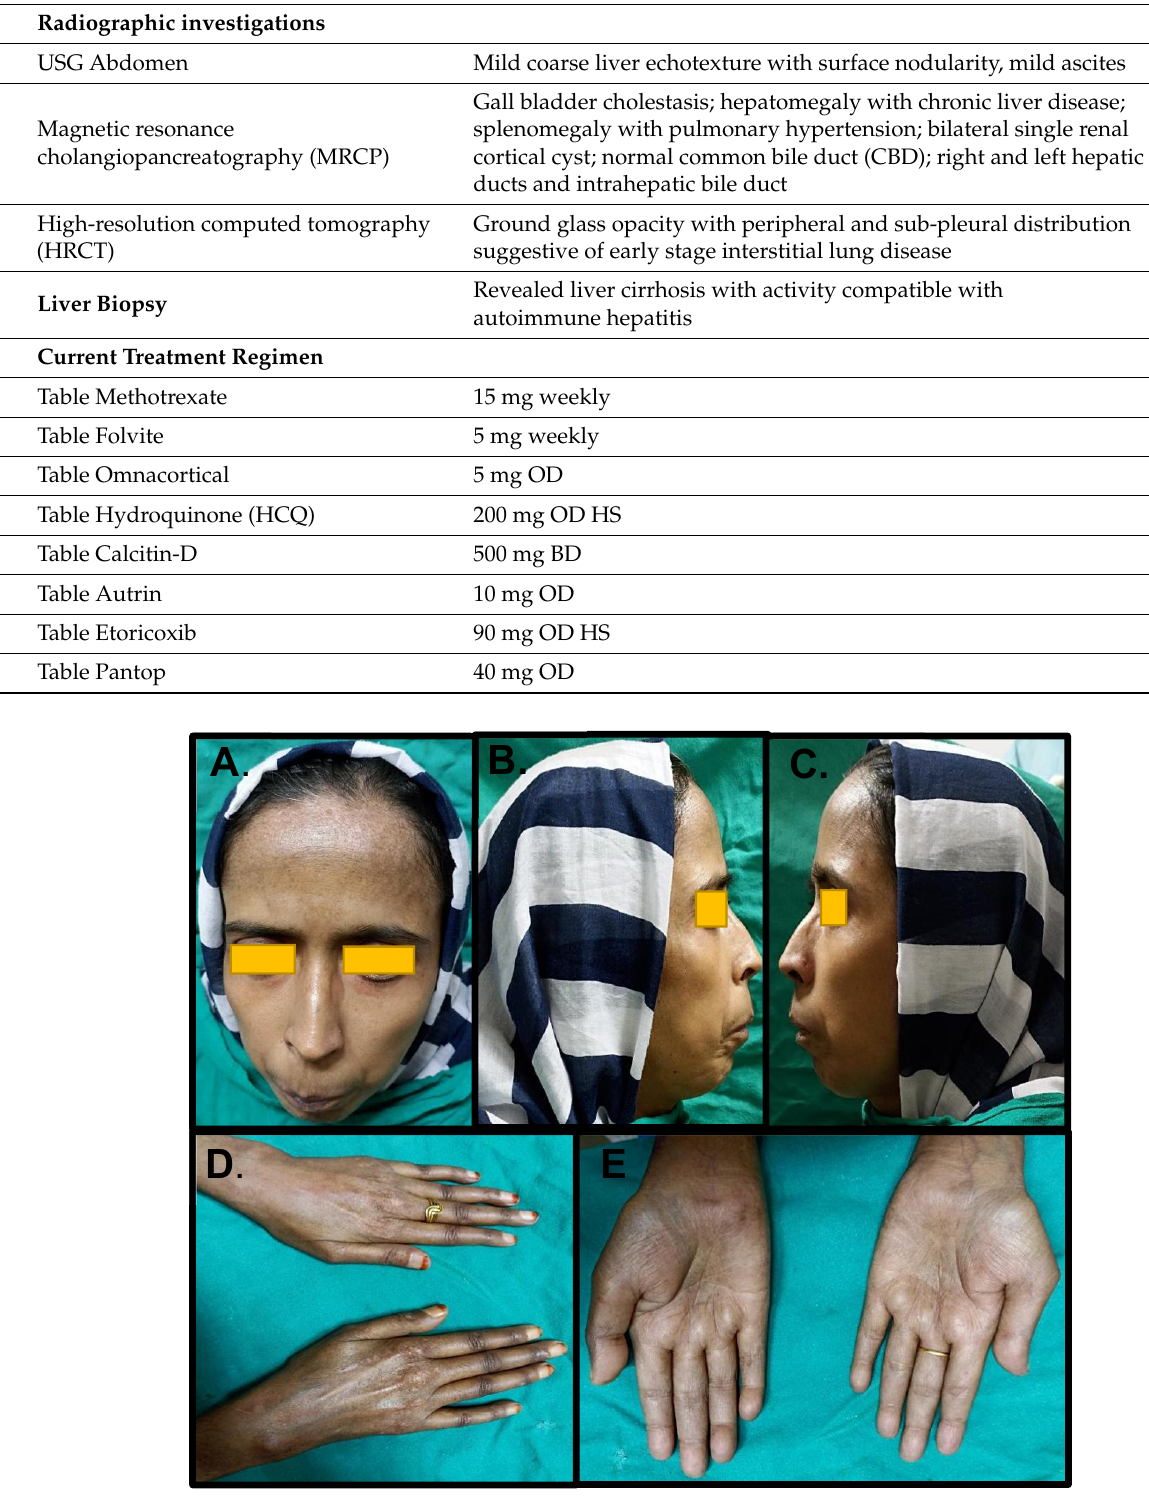
Figure 1. ( A )—Mask-like facies and salt and pepper appearance of the forehead ( B , C )—pinched nose, thin and incompetent lips, and ( D , E )—thick skin over hands and stiff joints. Intraoral examination revealed limited mouth opening (22 mm) and decreased inter- commisural distance (26 mm). Buccal and labial mucosa were pale, blanched, with palpa- ble fibrotic bands. The tongue was depapillated, rigid, and with restricted protrusive